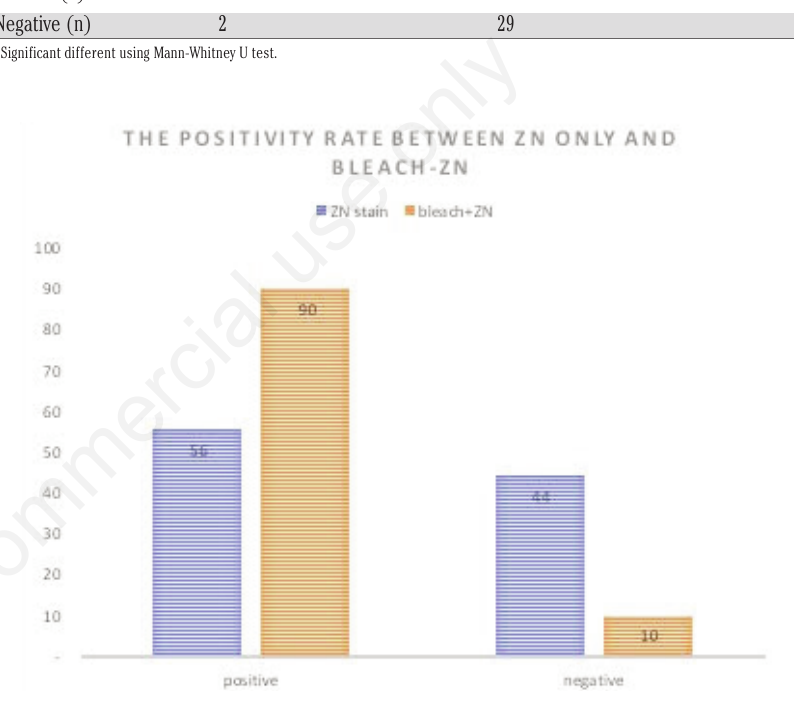
Figure 1. The positivity rate between ZN stain only and added 1% bleach-ZN stain in percentage value. (The positivity rate of ZN only is lower than bleach-ZN – 56% vs 90%).